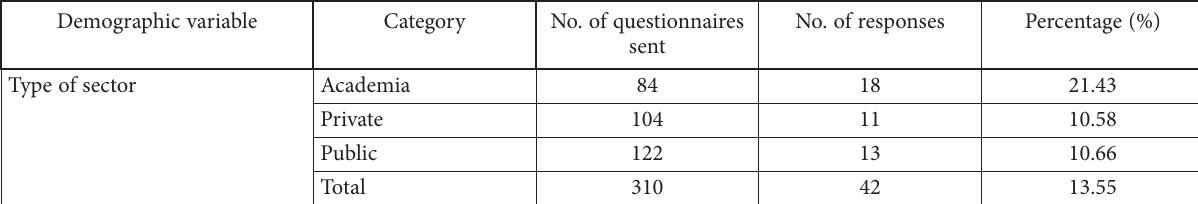
Table 2. Response rates for each group of stakeholder (Osei-Kyei & Chan, 2017) Demographic variable